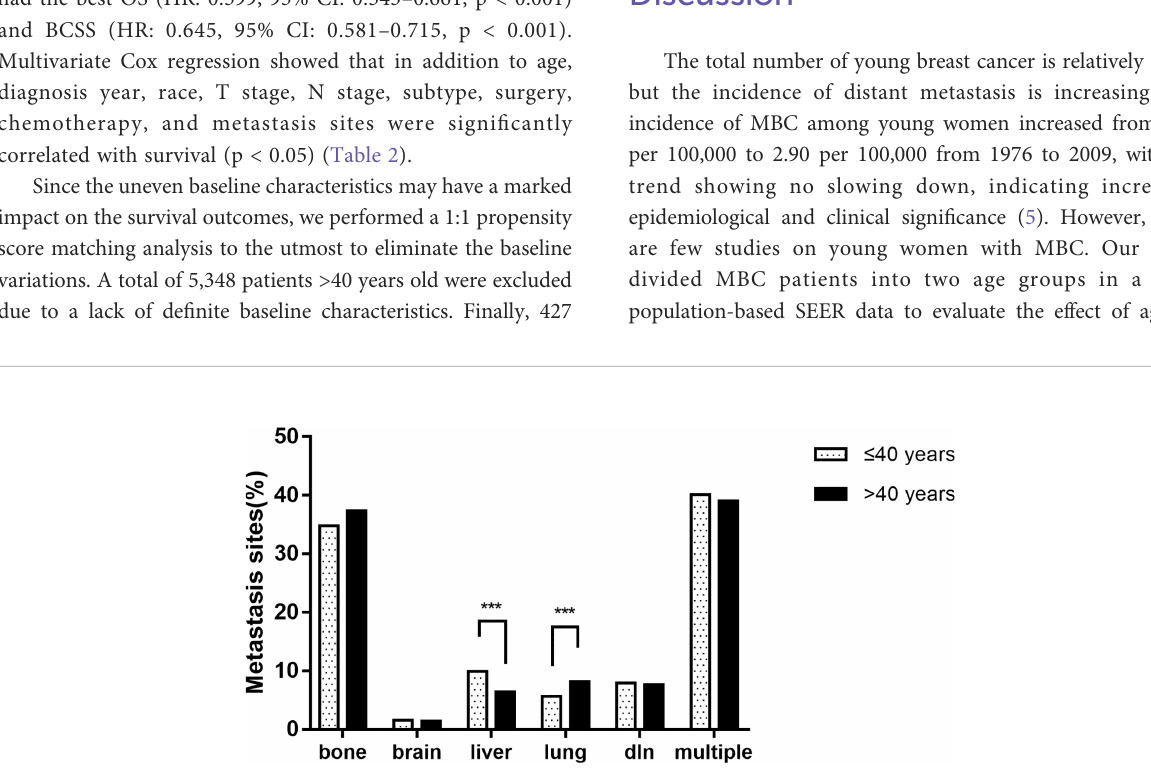
FIGURE 1 The proportion of metastatic sites of breast cancer patients between age groups (*** p <